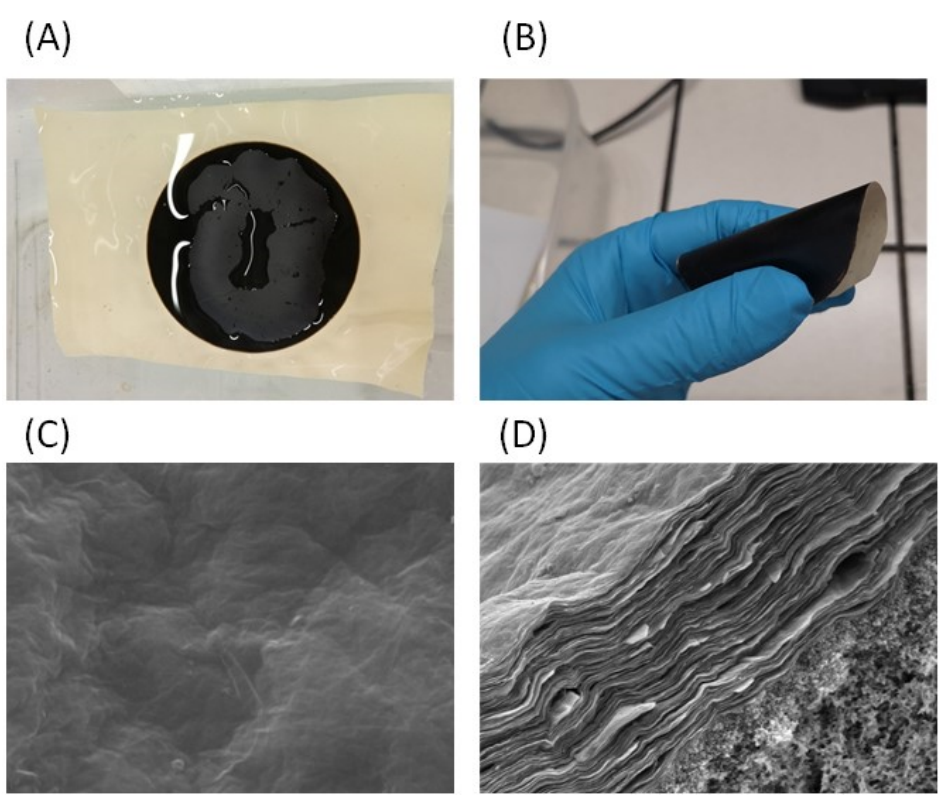
Figure 3. Composite GO membrane supported on the crosslinked co ‐ poly(amide ‐ imide) membrane. Pictures of the membrane ( A ) in wet and ( B ) dry state. SEM images of ( C ) the surface and the ( D ) cross section. Reprinted with permission from ref. [65] .